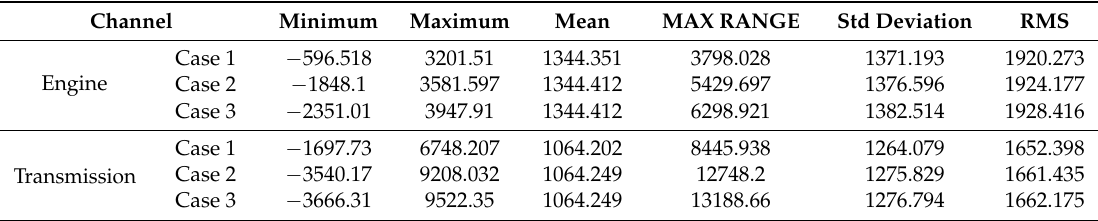
Table 2. Statistical results of the three simulation strategies (unit: Nm).